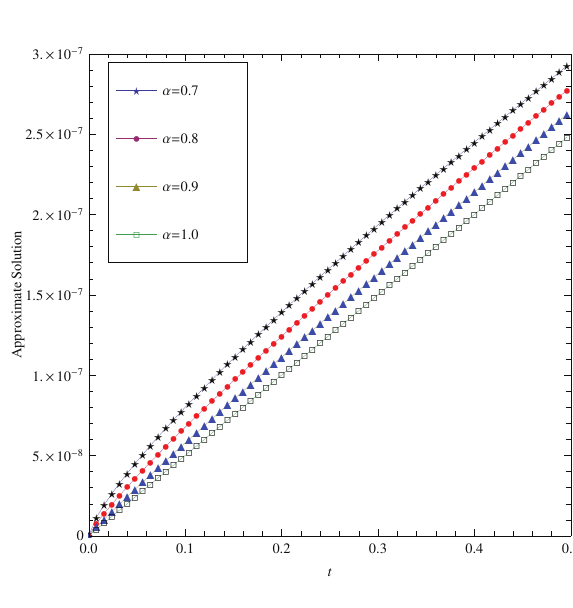
Fig. 5: Plot of u 3 ( x , t ) vs. time t at x = 1 and different value of α